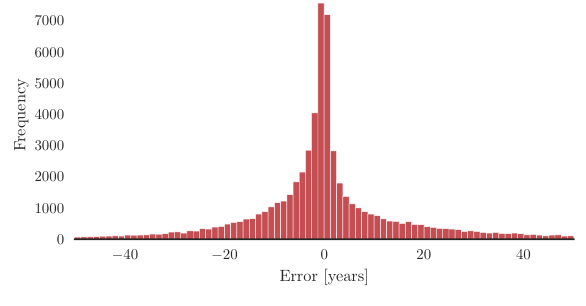
Figure 5. Histogram of errors for model